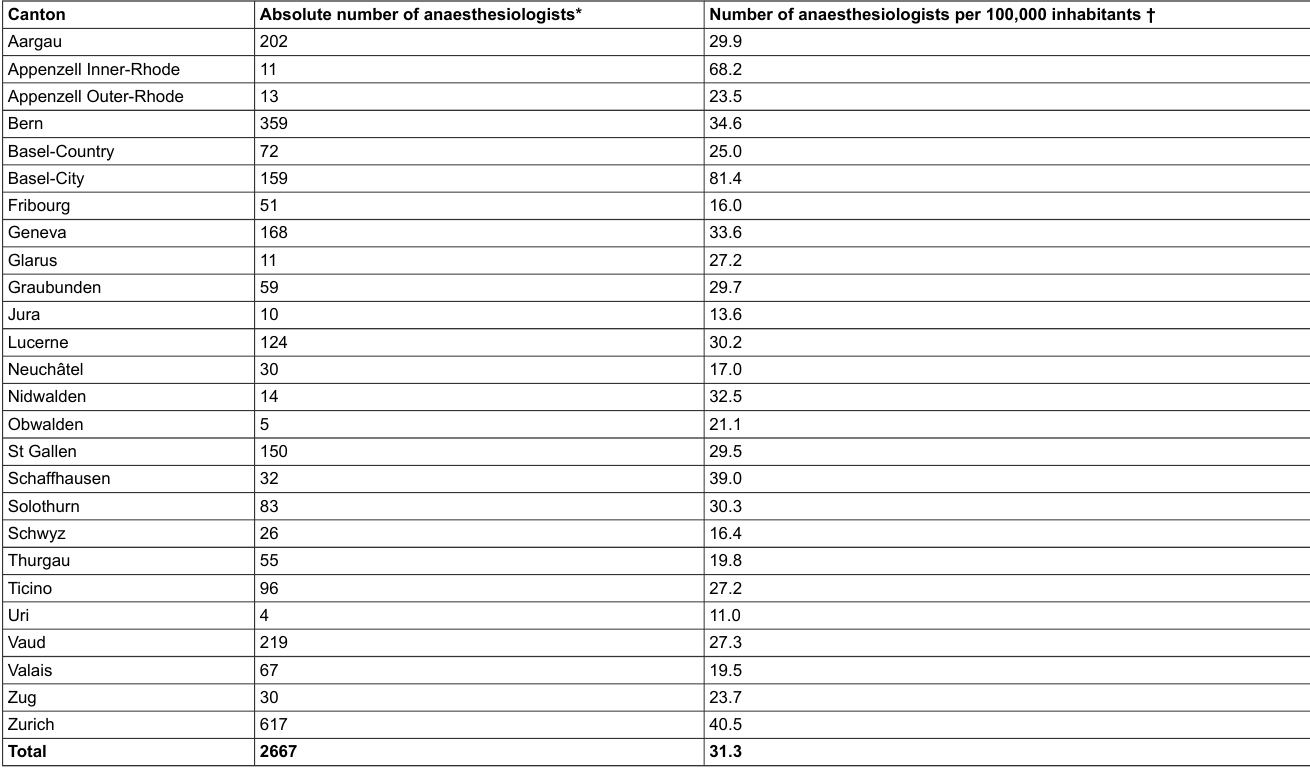
Table 1: Density of anaesthesiologists by cantons in Switzerland. Canton